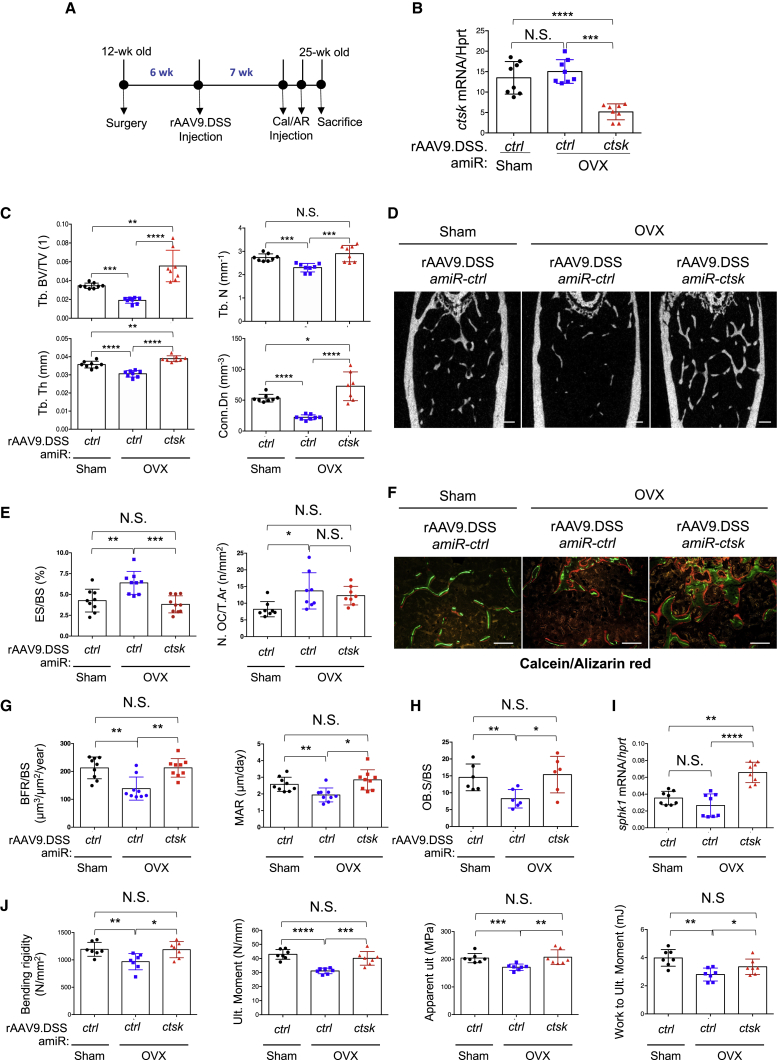
Bone-Targeting AAV9-Mediated Silencing of ctsk Reverses Bone Loss in a Mouse Model of Postmenopausal Osteoporosis(A) Timeline of the study and treatment methods. (B–J) Sham or OVX surgery was performed on 3-month-old female mice. Six weeks later, a single dose of 8 × 1011 GC of rAAV9.DSS-Nter carrying amiR-ctrl or amiR-ctsk was i.v. injected. (B) Seven weeks after injection, ctsk mRNA levels were assessed in the tibia (B, n = 8/group). Femoral trabecular bone mass was assessed by microCT. (C and D) Representative 3D reconstruction (D) and relative quantifications (C) are displayed (n = 8/group). (E–H) Histomorphometric quantification of ES/BS, N.OC/T.Ar (E), representative calcein/alizarin red labeling (F), BFR/BS, MAR (G), and OB.S/BS (H) are displayed (n = 8–9/group). (I) sphk1 mRNA levels in the tibia were assessed by RT-PCR and normalized to hprt (n = 8). (J) Femoral biomechanical properties, including bending rigidity and moment, apparent bending stress, and work to bending moment were quantified (n = 7/group). Values represent mean ± SD. *p < 0.05, **p < 0.01, ***p < 0.001, ****p < 0.0001 by an unpaired two-tailed Student’s t test and one-way ANOVA test. N.S., not significant.